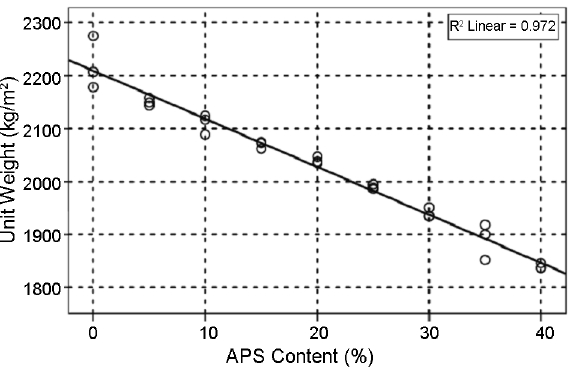
Fig. 2. Relationship between unit weight and APS content reduction in unit weight is a result of the lower unit weight of APS replacing the normal aggregates. The unit weight of the specimens is reported in Fig. 2.